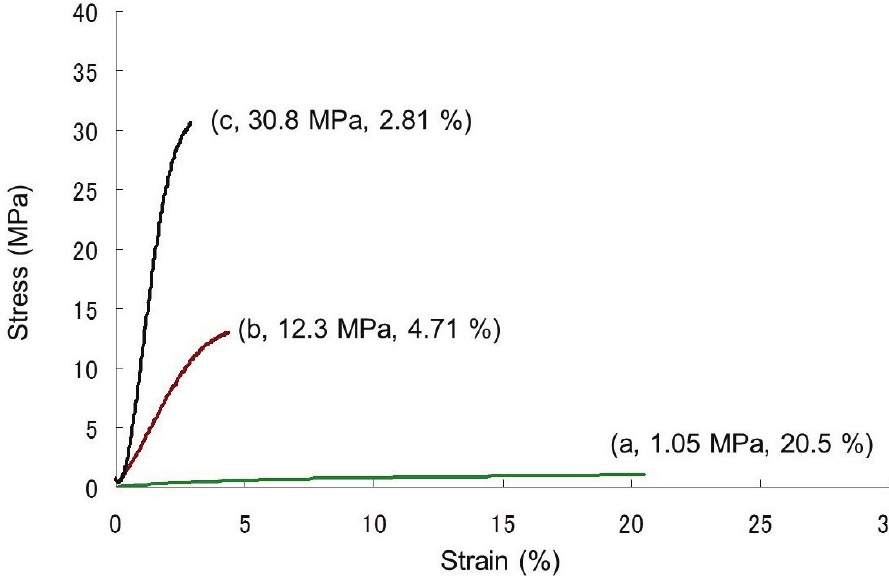
Figure 6. Stress-strain curves of regenerated cellulose materials obtained from cellulose ion gels by Soxhlet extraction with ethanol for 0.5 h ( a ); 1 h ( b ); and 4 h ( c ) (tensile